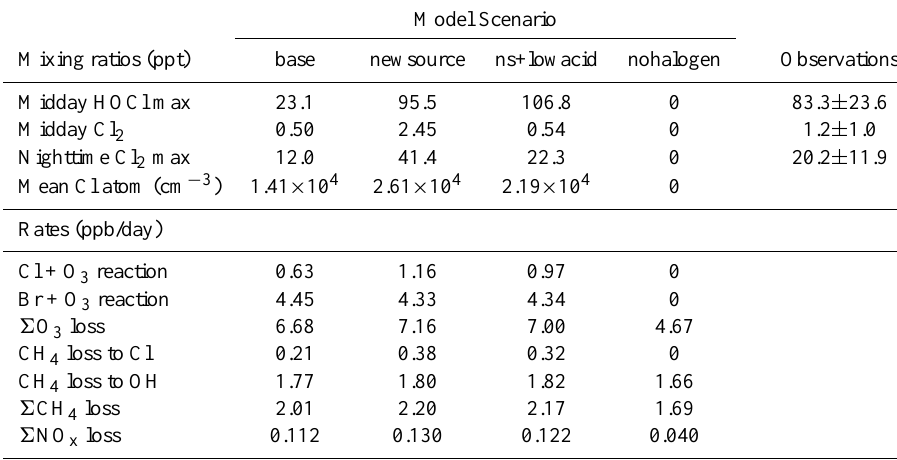
Table 4. Mixing ratios and rates for four model runs at day 9, by which time the model has reached pseudo-steady state. Mean HOCl and Cl 2 observations during the high Cl x period are given for comparison. The midday observational means for HOCl and Cl 2 include all data between 10:00–14:00LT, including points below detection. One standard deviation is